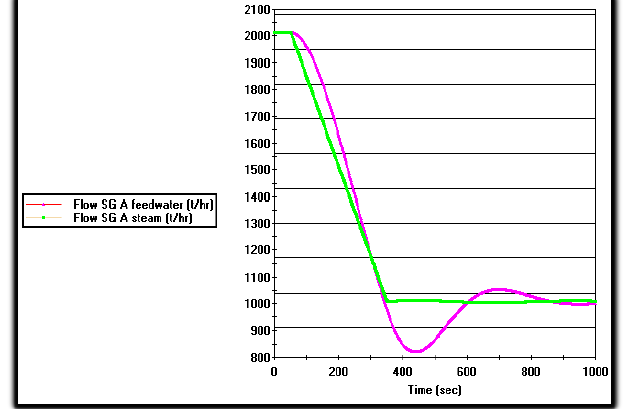
Fig. 13 . Dynamics of steam generator flows